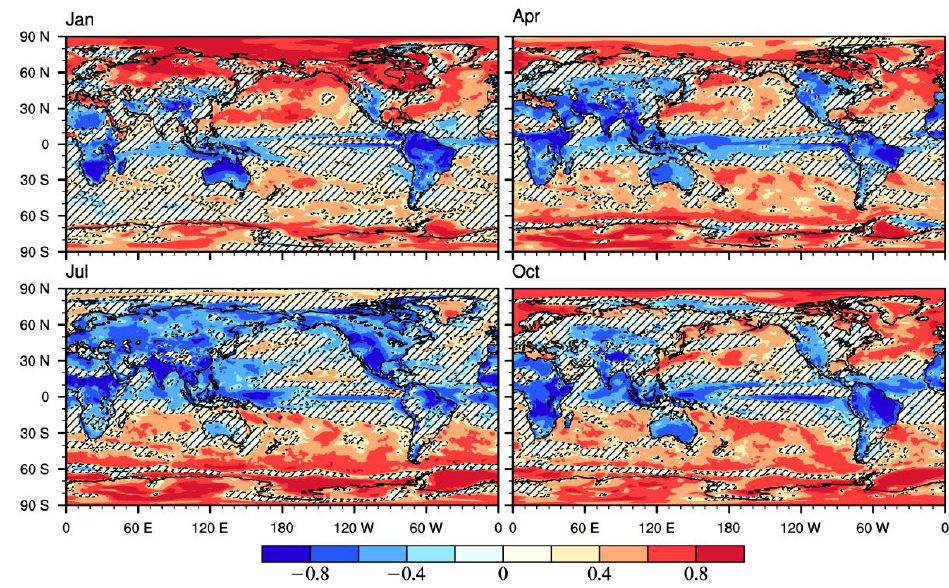
Figure 5. Distributions of the correlation coefficient between surface-air temperature T and relative humidity R .